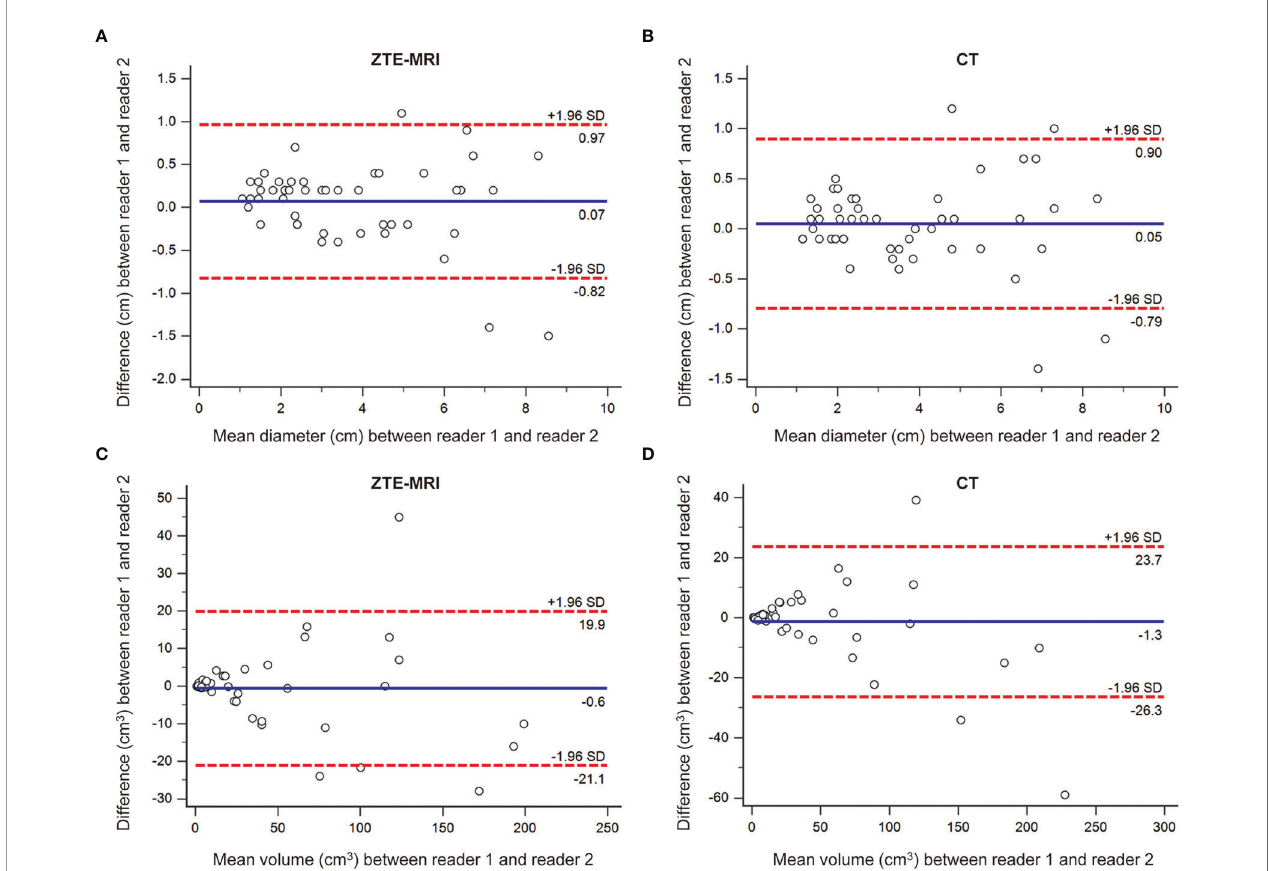
FIGURE 6 | Inter-observer agreement for lesion measurements on ZTE-MRI and CT. Bland – Altman plots show the agreements of diameter on ZTE-MRI (A) and CT (B) , and the agreements of volume on ZTE-MRI (C) and CT (D) .